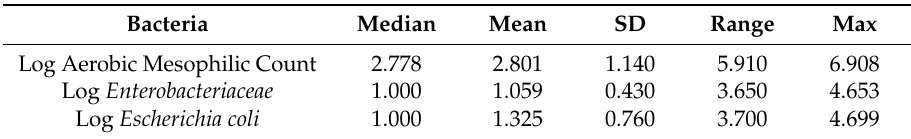
Table 4. Association between the presence of Enterobacteriaceae (Ent.) and farm characteristics estimated by a chi-square test. A p -value < 0.05 is considered to be statistically significant. Factor